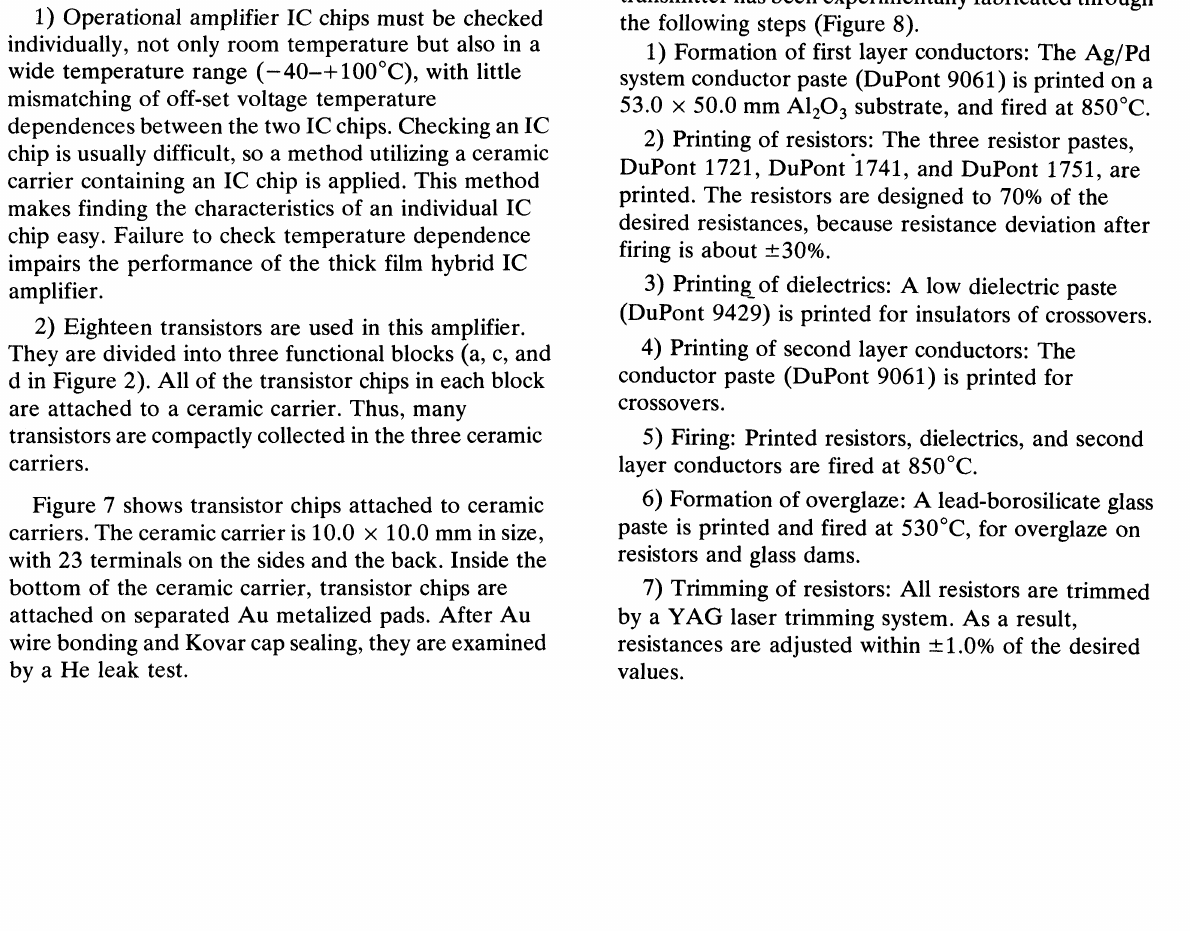
FIGURE 7 Ceramic carriers containing transistor chips. 1) for the amplifying block (4 chips); 2) for the quiescent current stabilizing and internal power supplying block (6 chips); 3) for the output current limiting block (8 chips); 4) hermetically sealed with Kovar